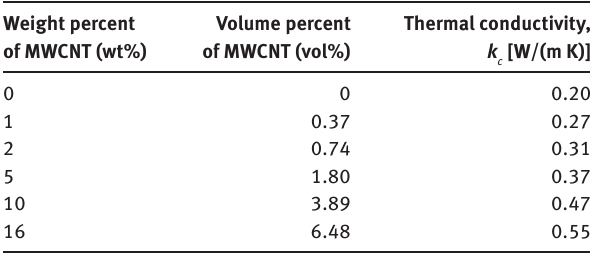
Table 1: Thermal conductivity of the experimental data of the PP + MWCNT specimens